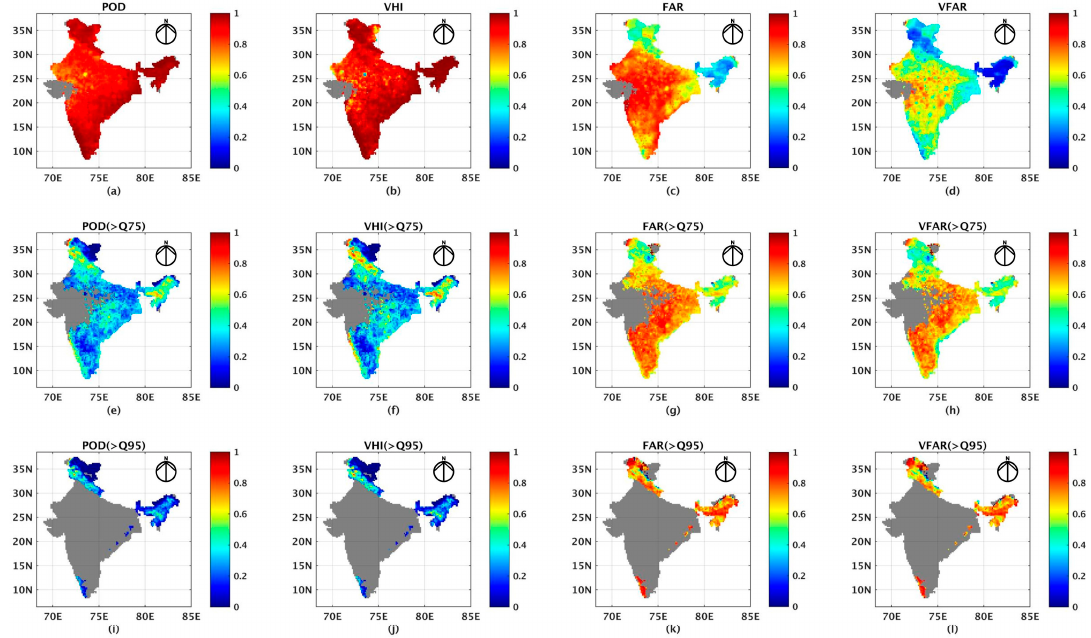
Figure 12. ( a – l ) Spatial distribution of categorical indices for the MAM months over India for daily and higher quantiles of precipitation using MSWEP and IMD daily precipitation data from 1979 to 2013 showing POD ( a , e , i ); VHI ( b , f , j ); FAR ( c , g , k ); and VFAR ( d , h , l ).